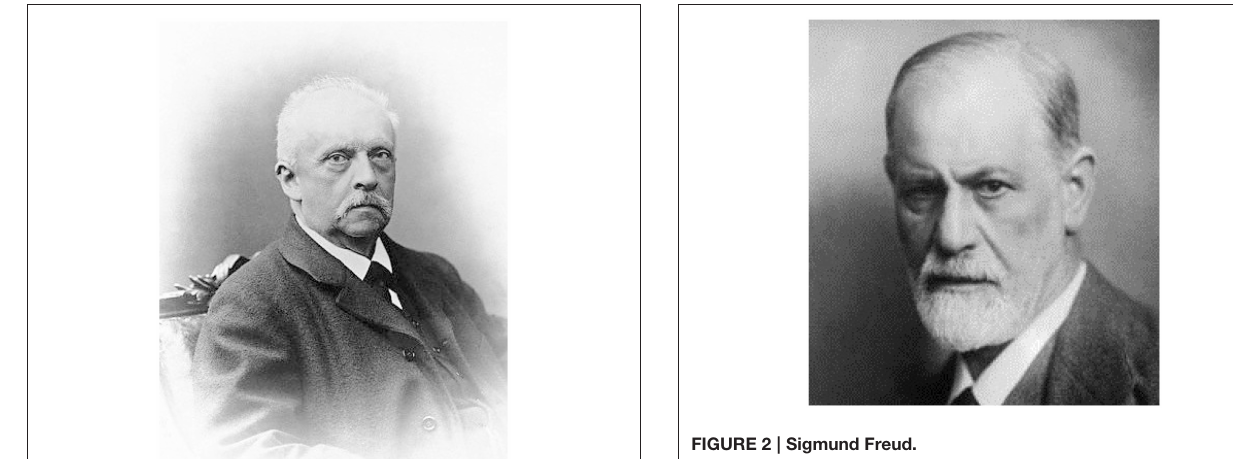
FIGURE 2 | Sigmund Freud.